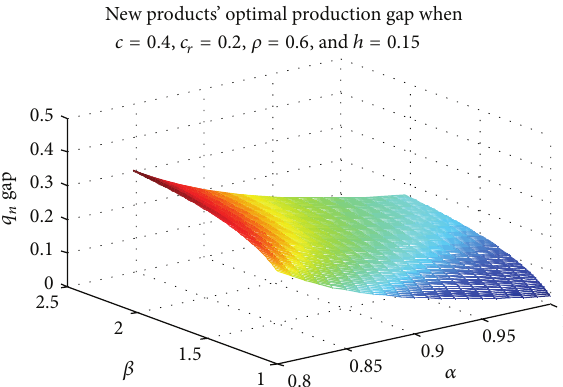
Figure 5: Consumers’ perceived value impact on Δ𝑞 𝑛 .